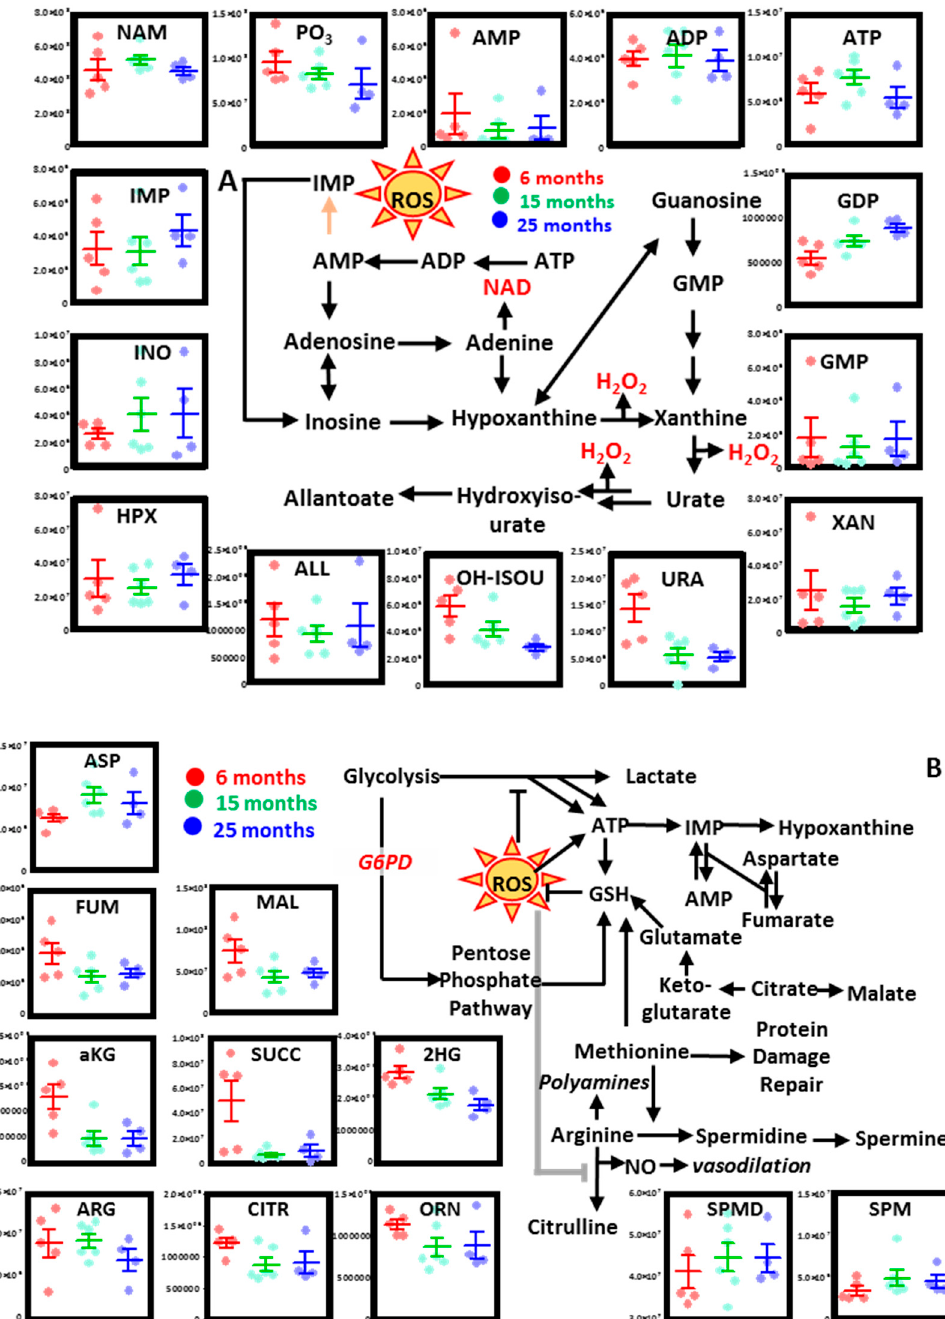
Figure 3. Alterations of purine metabolism ( A ), and carboxylic acid and arginine metabolism ( B ) in mouse RBCs as a function of aging. Dots represent distinct biological replicates for six- (red), 15- (green), and 25-month-old mice